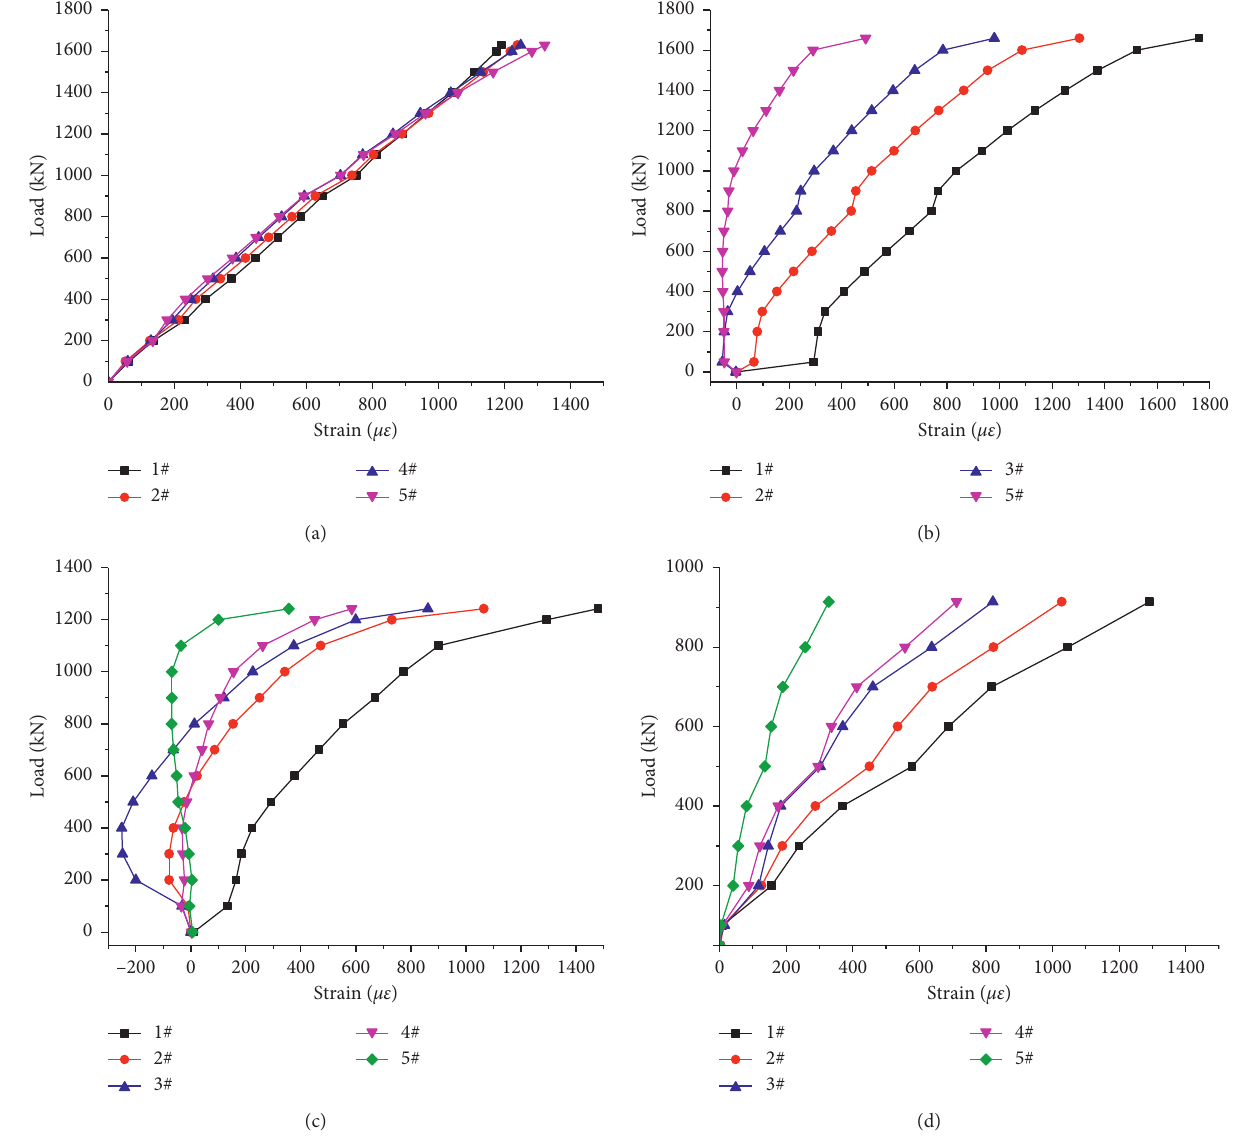
Figure 7: Load-strain diagrams of group N : (a) N70-L-00. (b) N70-L-20. (c) N70-L-30. (d)